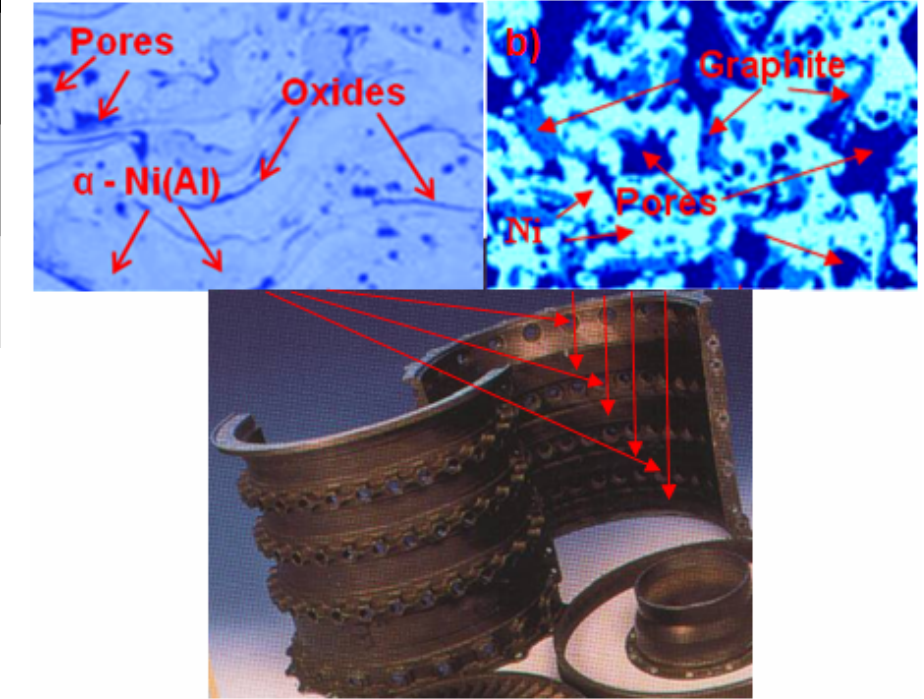
Figure 2 – The compressor front body in the TV2 - 117 A turbojet engine and the microstructures of the system of the NiAl / Ni-15% graphite sealing coating Slika 2 – Prednje telo kompresora turbomlaznog motora TV2 - 117